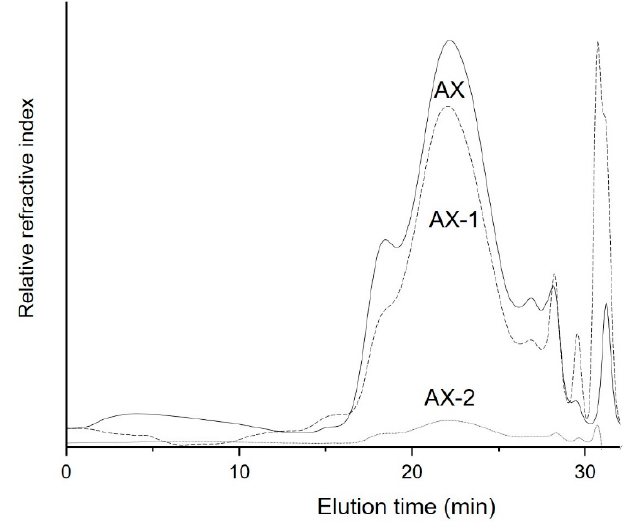
Figure 1. SE-HPLC (size-exclusion high-performance liquid chromatography) chromatograms of AX treated with different ultrasonic conditions. AX = untreated AX, AX-1 = AX treated with 25% power for 15 min, AX-2 = AX treated with 50% power for 15 min.